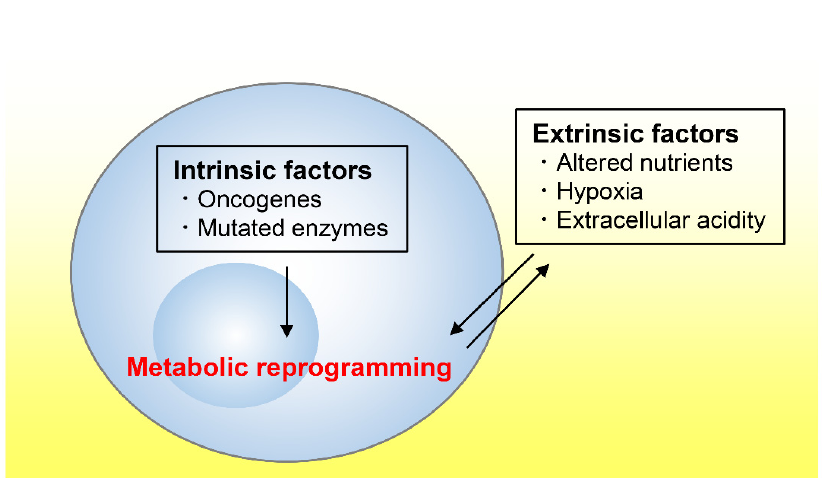
Figure 1. Schematic view of metabolic reprograming of cancer cells. Both intrinsic and extrinsic factors induce metabolic reprograming of cancer cells. Intrinsic factors include oncogene and mutated enzymes, and extrinsic factors include altered nutrients, hypoxia, and extracellular acidity in tumor microenvironments.